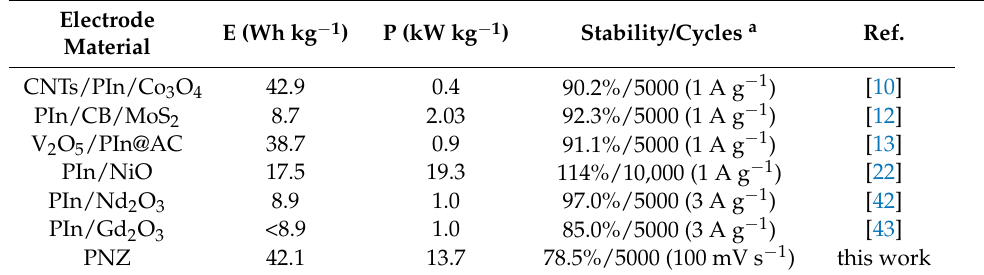
Table 1. Comparison of various polyindole metal oxide supercapacitors.